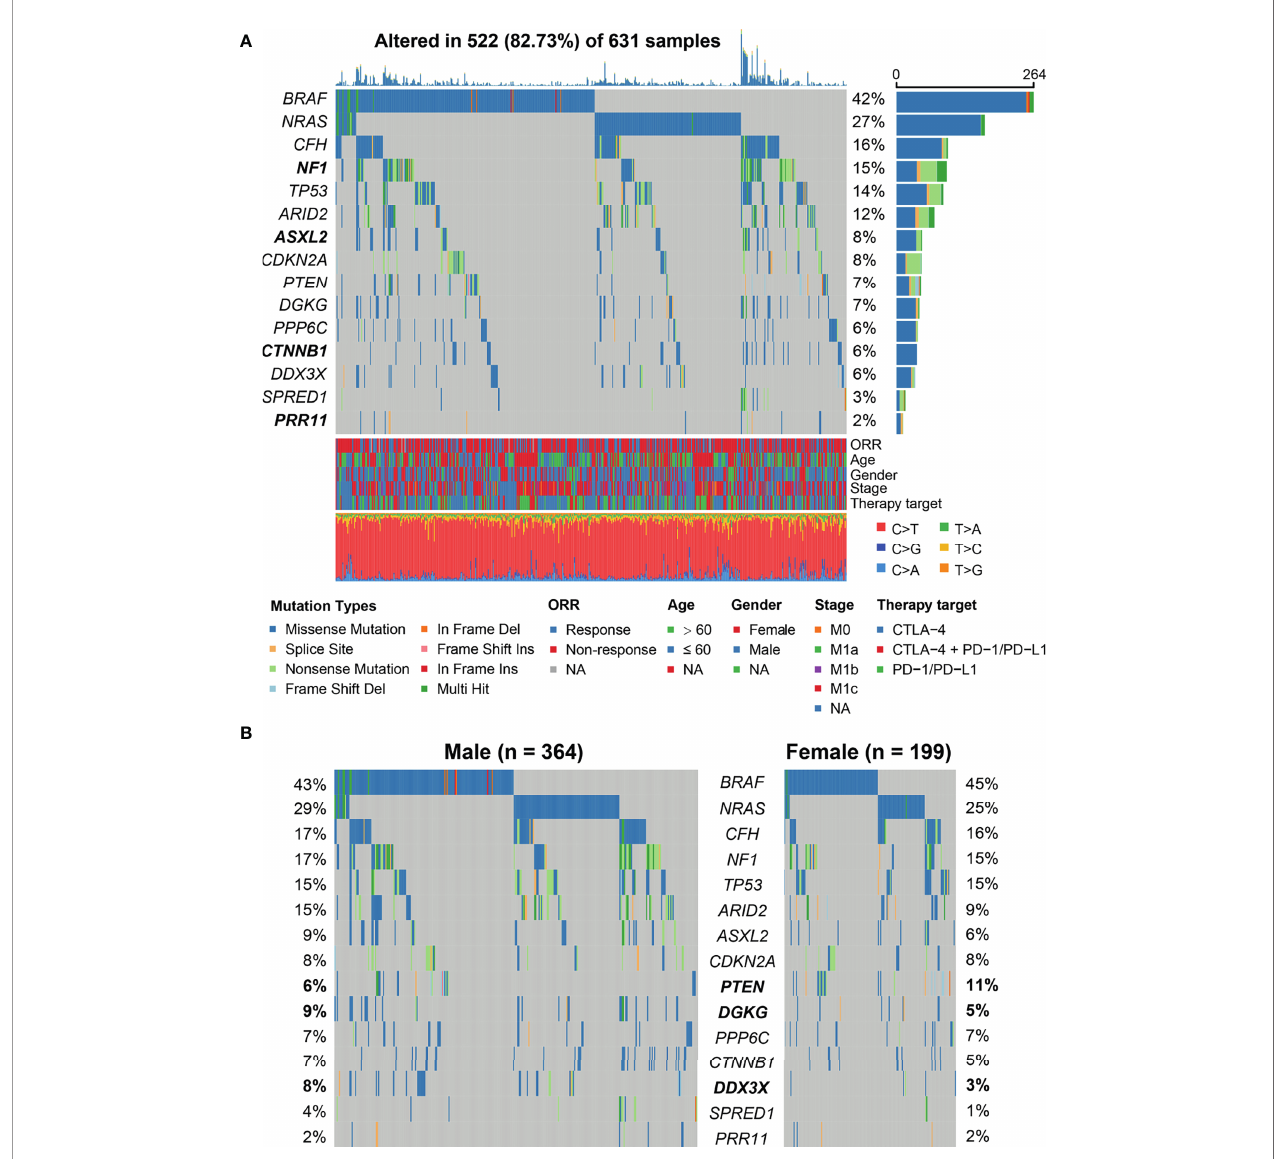
FIGURE 1 | Identi fi cation of signi fi cantly mutated genes (SMGs) in the aggregated melanoma cohort and their sex-biased mutation distributions. (A) Waterfall plot representation of mutational patterns of the identi fi ed SMGs. The left panel shows the gene symbols, the upper panel indicates the non-synonymous mutation counts for each patient, the middle plot illustrates the mutational patterns of the identi fi ed 15 SMGs with different mutation types colored differently, the right panel shows the mutation rate of each SMG, and the bottom panel indicates the clinical characteristics and base substitution categories. Genes highlighted in bold are the SMGs that were not previously reported. (B) Distinct mutation rates of the identi fi ed 15 SMGs between male and female patients. SMGs that were signi fi cantly differentially mutated between the two subgroups were highlighted in